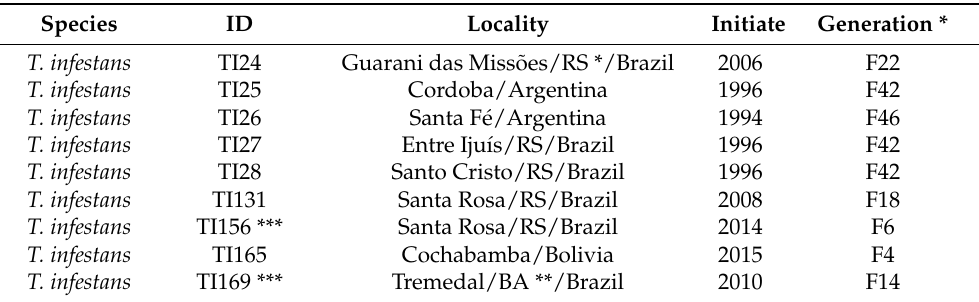
Figure 1. Distribution of the occurrence of T. infestans in Argentina, Bolivia, and residual foci in Brazil in the states of Bahia and Rio Grande do Sul. Table 1. Origin of T. infestans populations.